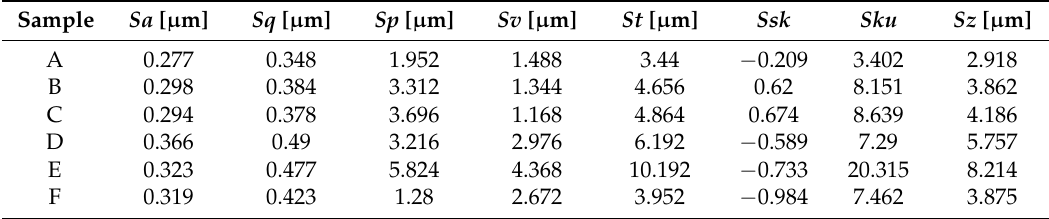
Table 4. Amplitude parameters of surface geometric structure.